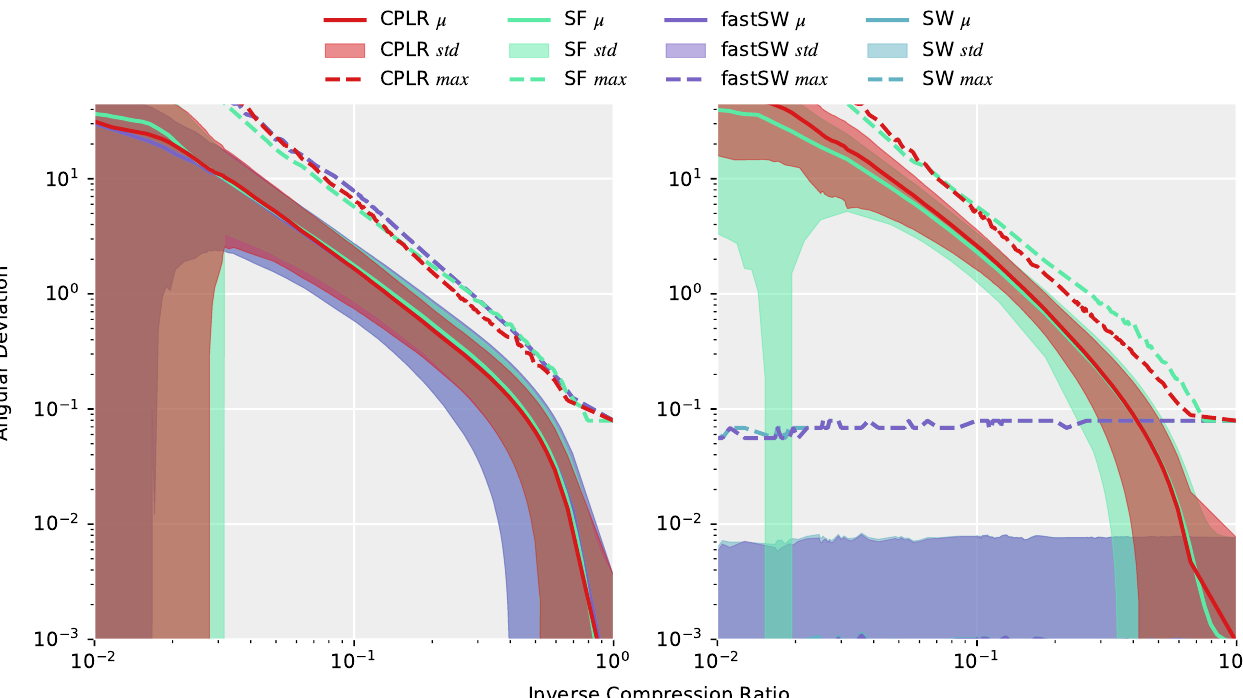
Figure 4. Left : Average (solid line), standard deviation (shaded area), and maximum (dashed line) of angular deviations of the approximations of the entire TNT15 dataset with CPLR, SF, SW, and fastSW from the original signal after interpolating the produced segment points using spherical linear interpolation (SLERP). Right : Average, standard deviation, and maximum of angular deviations of only the segments points of the same approximations. Values are plotted against the resulting inverse compression ratio (ICR) at a high range of different threshold values. Colors of the shaded regions denoting the standard deviations mix up and may extend over the whole plot at smaller ICRs due to the logarithmic scale of the y-axis. While differences of the methods on the reconstructed signal ( left plot ) are not obvious, the differences of the segment points themselves ( right plot ) are significant. CPLR and SF show increasing angular deviations of their segment points with decreasing ICR. The segment points of SW and fastSW, on the other hand, are not affected by the ICR and show constant angular deviations at a small scale caused by numerical